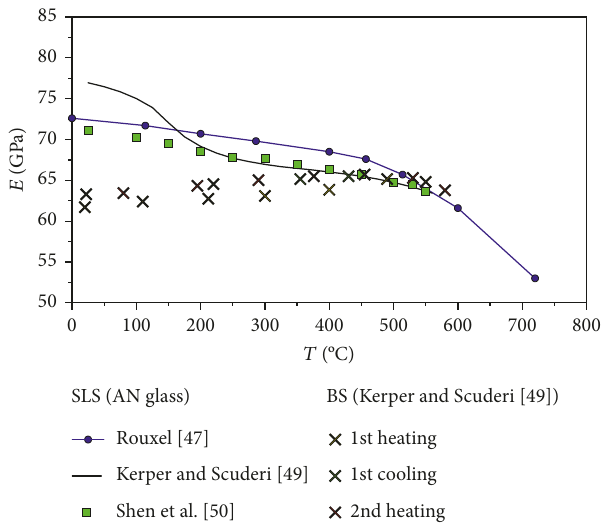
Figure 5: MOE variation as a function of temperature, for SLS annealed and BS glass